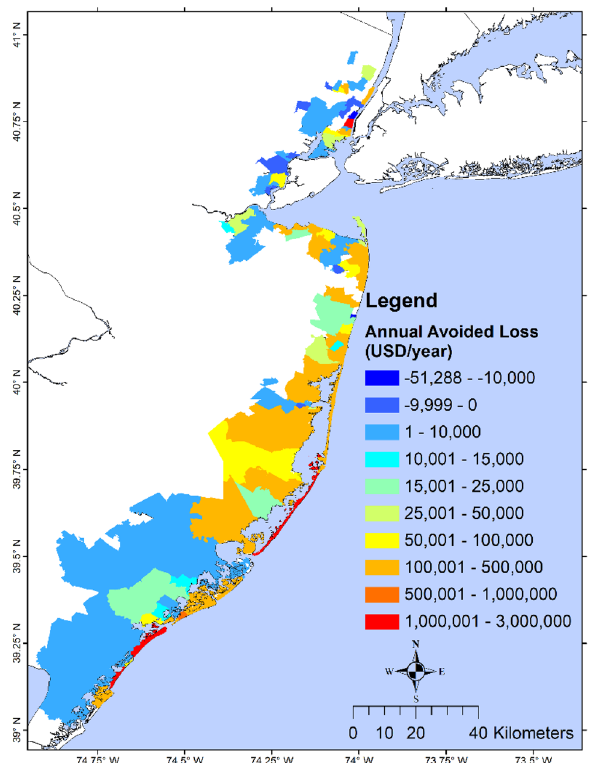
Figure 5. Wetland annual avoided losses for all NJ zip-codes. Map showing zip-code resolution avoided losses. Annual avoided loss is calculated as the difference in losses for the without wetland and with wetland scenarios using the 1% annual chance flood and wave map and then dividing it by 100 years. Dark blue values show zip- code with the lowest wetland value/benefit, while red areas have the highest wetland value/benefit. Negative values indicate that the presence of wetlands would increase structural loss and positive values indicate that wetlands would lower structural loss. Negative values are relatively small while only increasing losses by ~ $10 thousand per year. The map is produced using ESRI ArcGIS Pro 2.7 (https ://www.esri.com/en-us/arcgi s/produ cts/arcgi s-pro/overv iew).